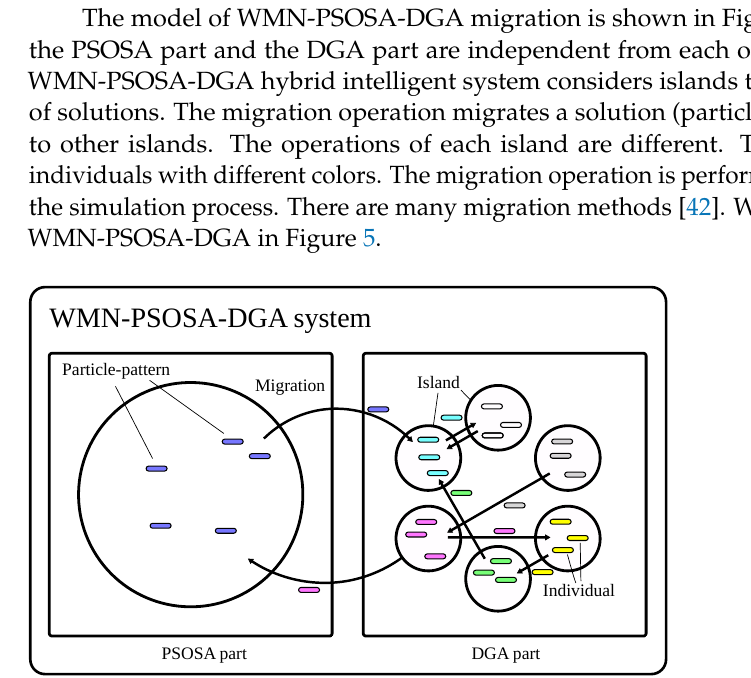
Figure 4. Model of WMN-PSOSA-DGA migration.